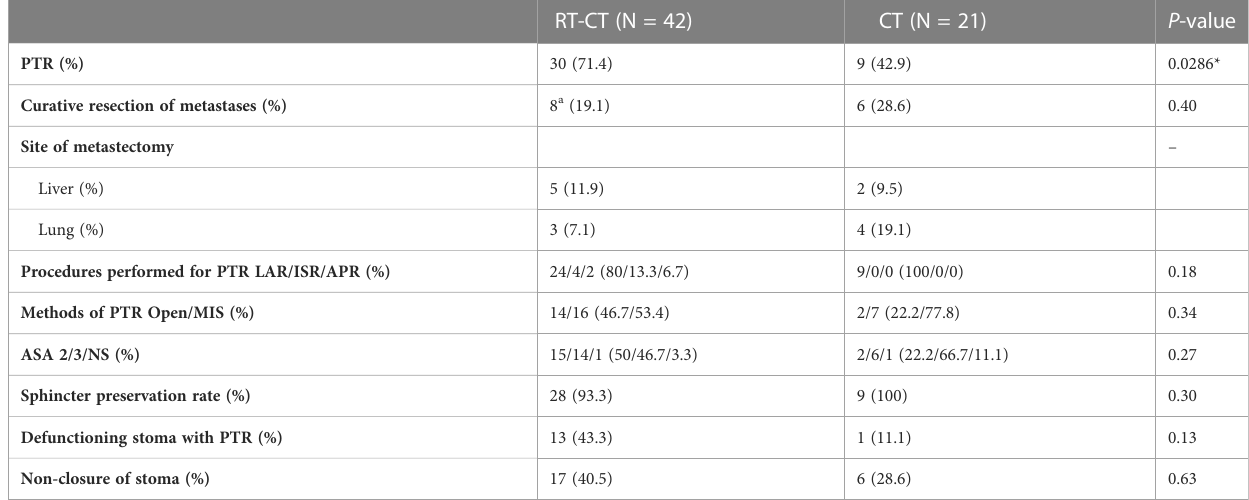
TABLE 3 Perioperative data and surgical outcomes recorded in the RT-CT 1 and CT 2